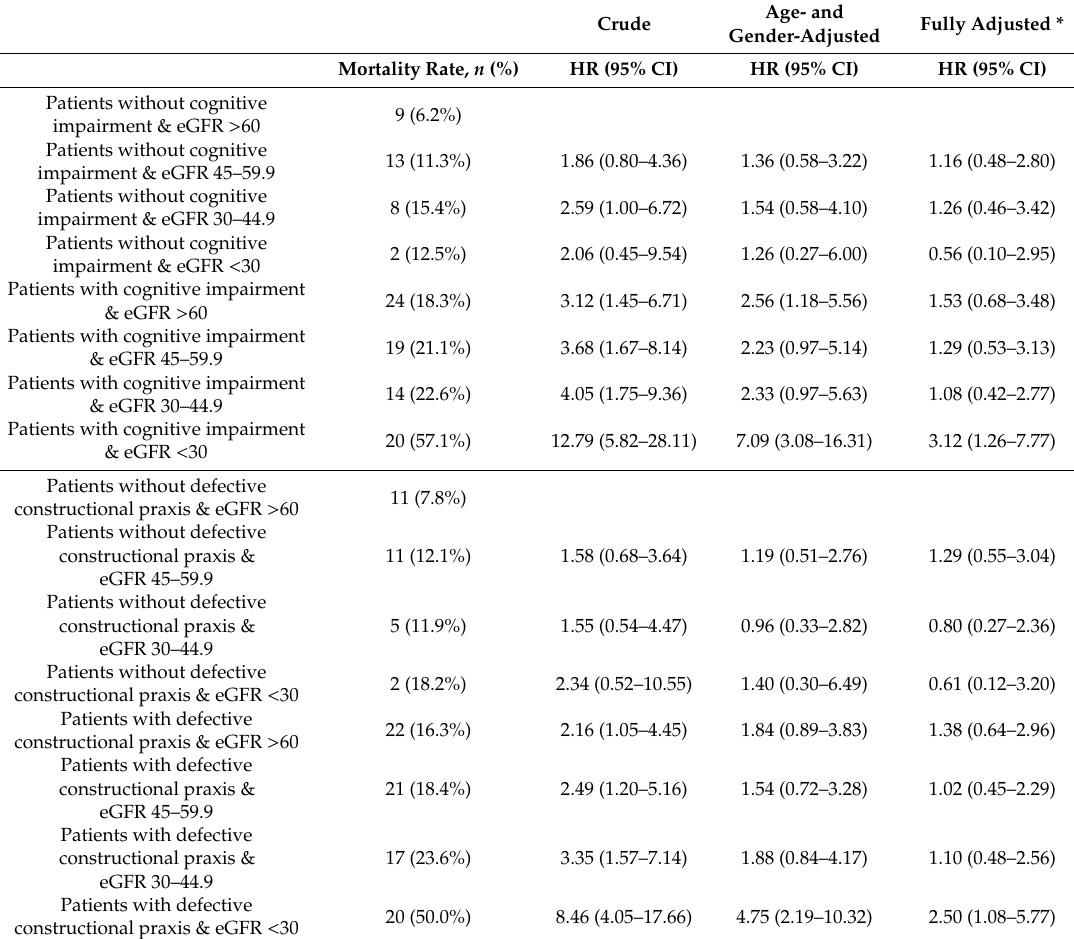
Table 2. Cox regression analysis of eGFR with or without overall cognitive impairment or defective constructional praxis to 1-year